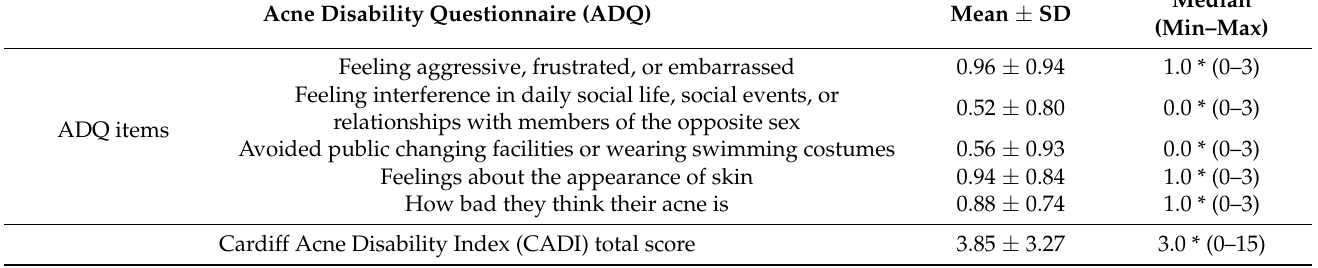
Table 3. The Acne Disability Questionnaire (ADQ) detailed results accompanied by the Cardiff Acne Disability Index (CADI) in the group of Polish female adolescents participating in the